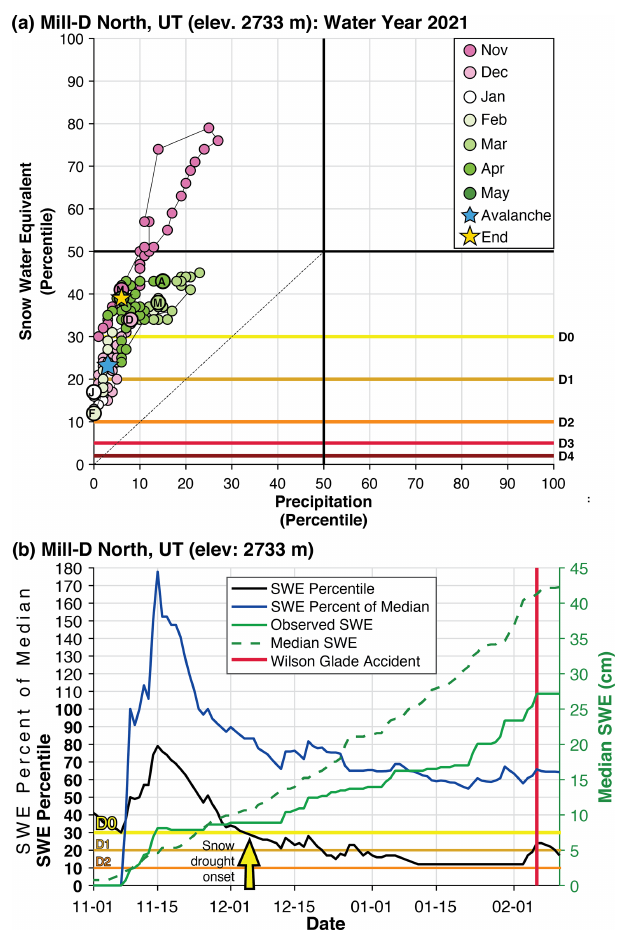
Figure 10. (a) Phase diagram for Mill-D North SNOTEL in the Wasatch Mountains of Utah for WY 2021. (b) Time series of snow water equivalent (SWE) percentile (bold; left y axis) and percent of median (left y axis) and observed and median SWE (cm; dark-blue and dashed green lines, respectively; right y axis). The vertical red line shows the date of the Wilson Glade Avalanche accident. The horizontal gold line shows the percentile associated with the onset of snow drought conditions